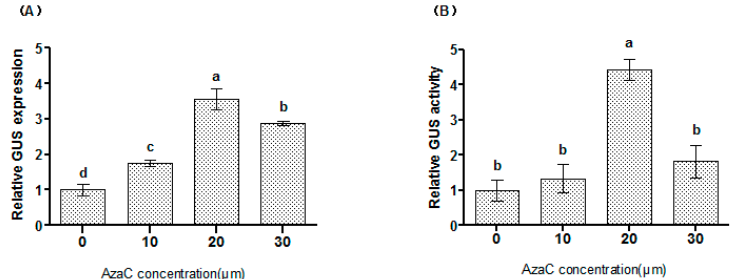
Figure 1. Effects of 5-azacytidine (AzaC) on the transformation efficiency. The expression ( A ) and activity ( B ) of the β -glucuronidase ( GUS ) transgene were analyzed to determine syringe agroinfiltration efficiency. ( A ) GUS expression analysis to study the transformation efficiency. The expression of GUS in the control (no AzaC supplement) was used as a calibrator to normalize the expression of GUS at different concentrations of AzaC (the ratio of the expression of GUS at different concentrations of AzaC was divided by the GUS expression without AzaC supplement); ( B ) GUS activity analysis to determine the effects of AzaC on syringe agroinfiltration efficiency. GUS activity without AzaC was used as a calibrator to normalize the results of different AzaC levels (the ratio of GUS activity at different concentrations of AzaC was divided by the GUS expression without AzaC supplement). a, b, c, d means not sharing a common superscript differ significantly according to ANOVA Tukey’s test ( p < 0.05).